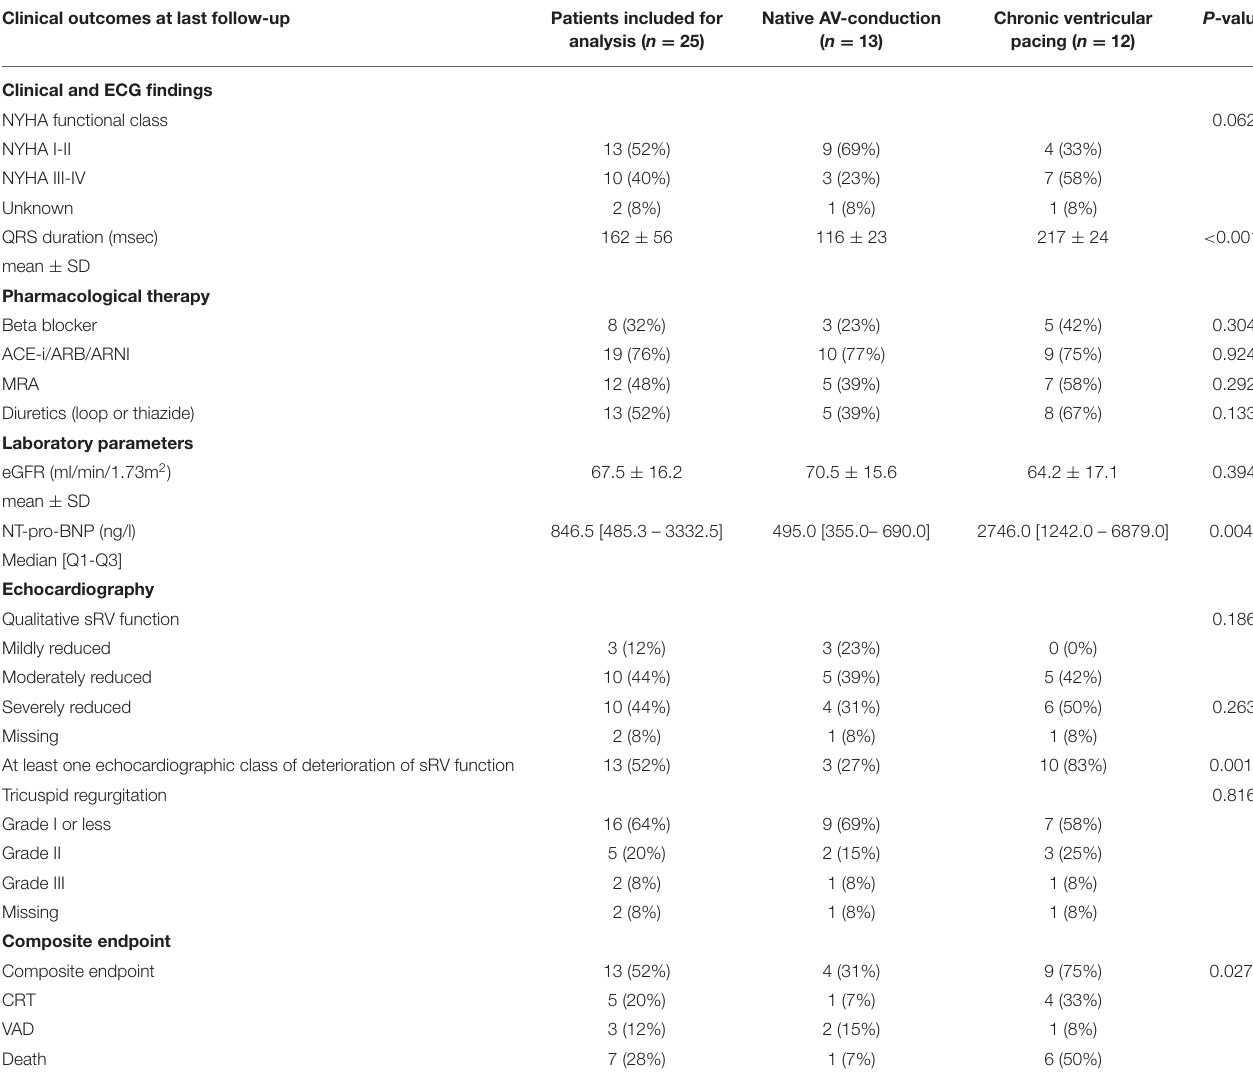
TABLE 2 | Clinical outcomes at last follow-up, patients with cardiac resynchronization therapy before and concomitant TV surgery were excluded from analysis ( n = 2). Clinical outcomes at last follow-up Patients included for